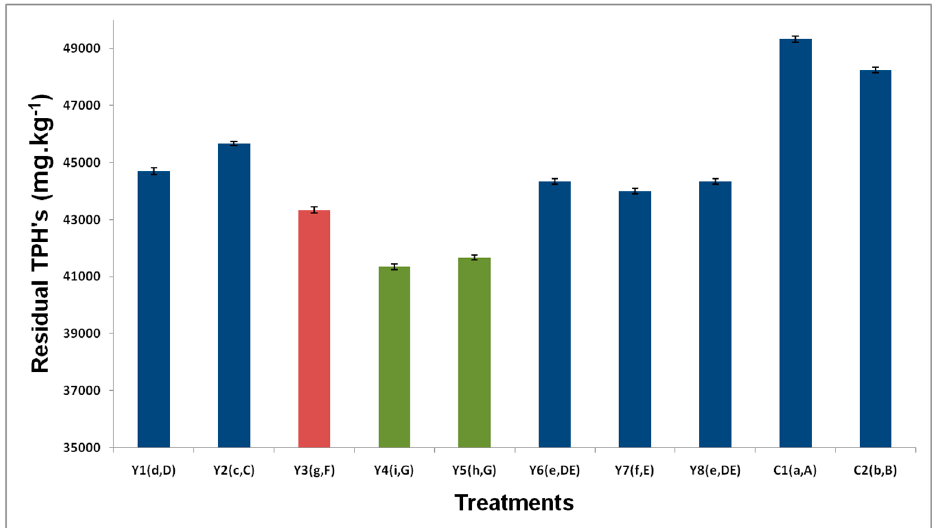
Figure 1. Removal of total petroleum hydrocarbons (TPHs), applying different biostimulation treatments. Standard deviation of the means (I). “a,A”: The lower case and uppercase letters in parentheses correspond to the differences between means of the LSD and Tukey tests, respectively.